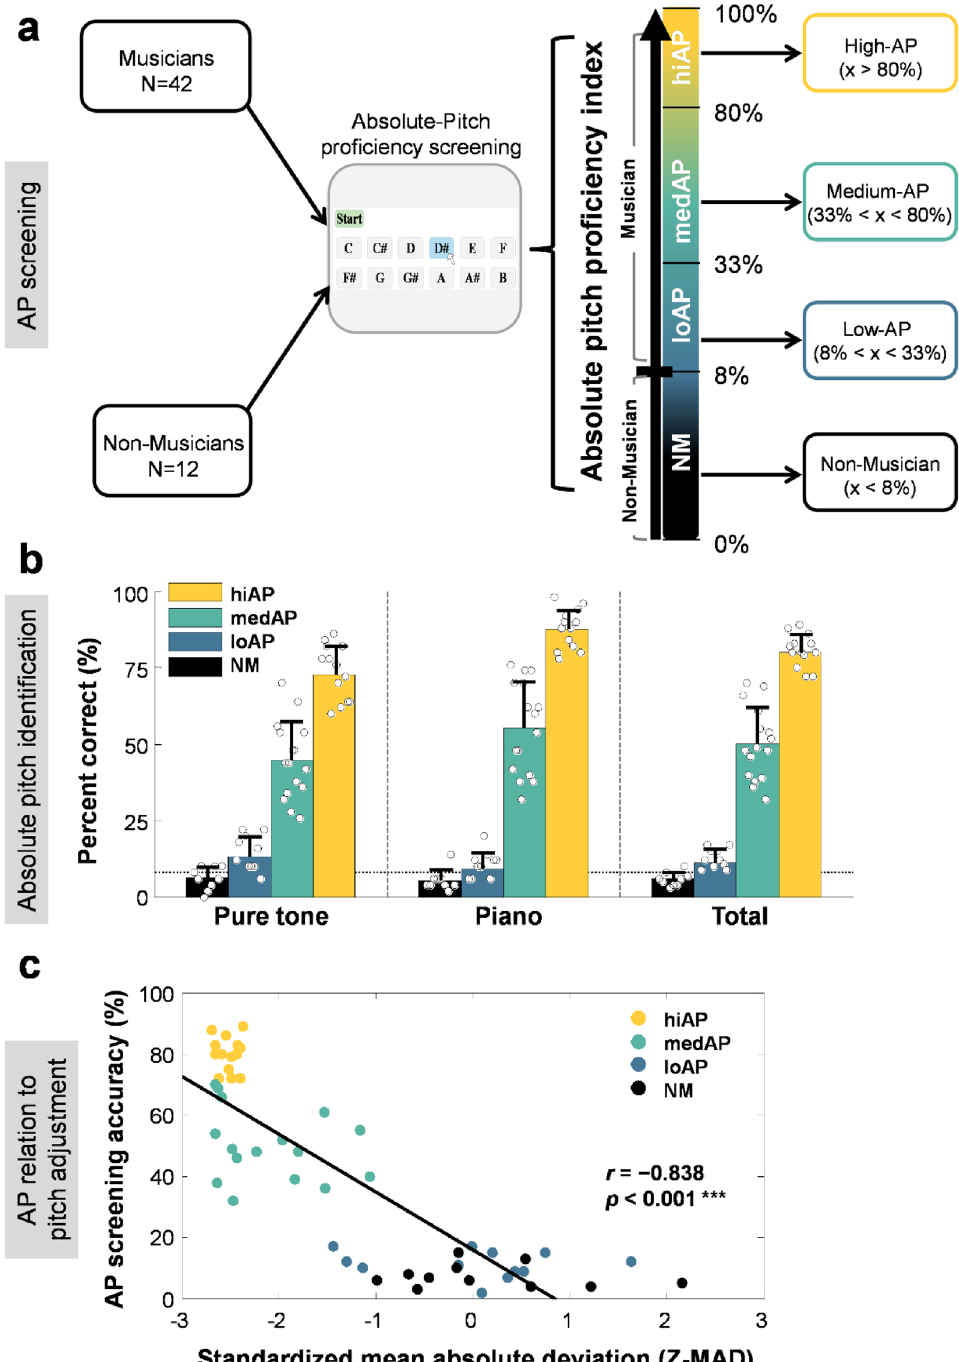
Figure 1. Performance on absolute pitch screening and pitch adjustment for the participants grouped by levels of absolute pitch proficiency. ( a ) Absolute pitch proficiency index. Participants were separated into four groups based on the gradient performance on AP screening tasks. High-AP: 80% or above; med-AP: 33–80%; low-AP: 8–33% and non-musicians: below 8% (chance performance). ( b ) Percent correct performance on absolute pitch identification of pure tone and piano for the high-AP, med-AP, low-AP musicians, and non-musician groups. ( c ) Relationship between pitch adjustment performance (standardized mean absolute deviation) and AP screening score for the four AP proficiency groups. Higher scores on AP screening are associated with smaller mean absolute deviation from target-tone frequency on pitch adjustment task. Z-MAD: z transformed mean absolute deviation in semitones normalized in reference to the non-musician